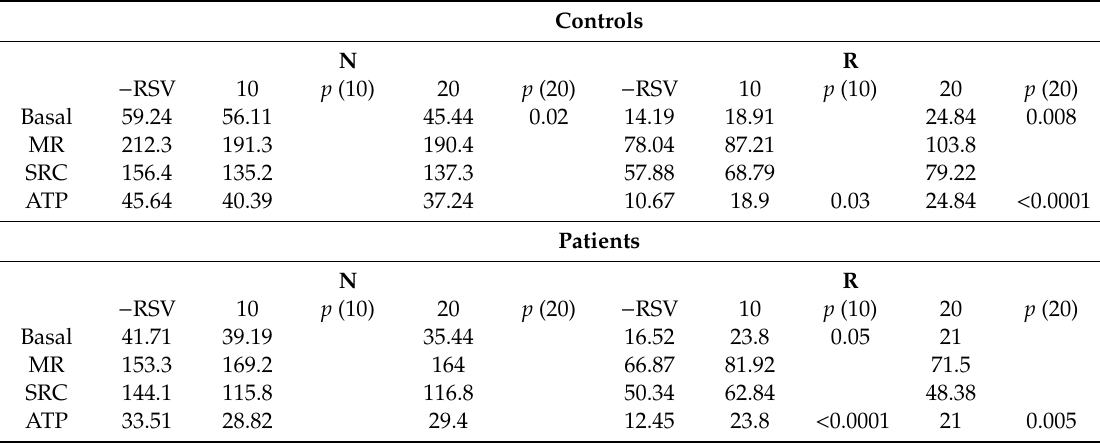
Table 4. Comparison of the e ff ect of 10 or 20 µ M RSV on basal, MR, ATP production, and SRC measured under normal (N) or restricted (R) conditions in patients (n = 5) and controls (n = 5). p values are only shown in the case of a significant di ff erence between the two